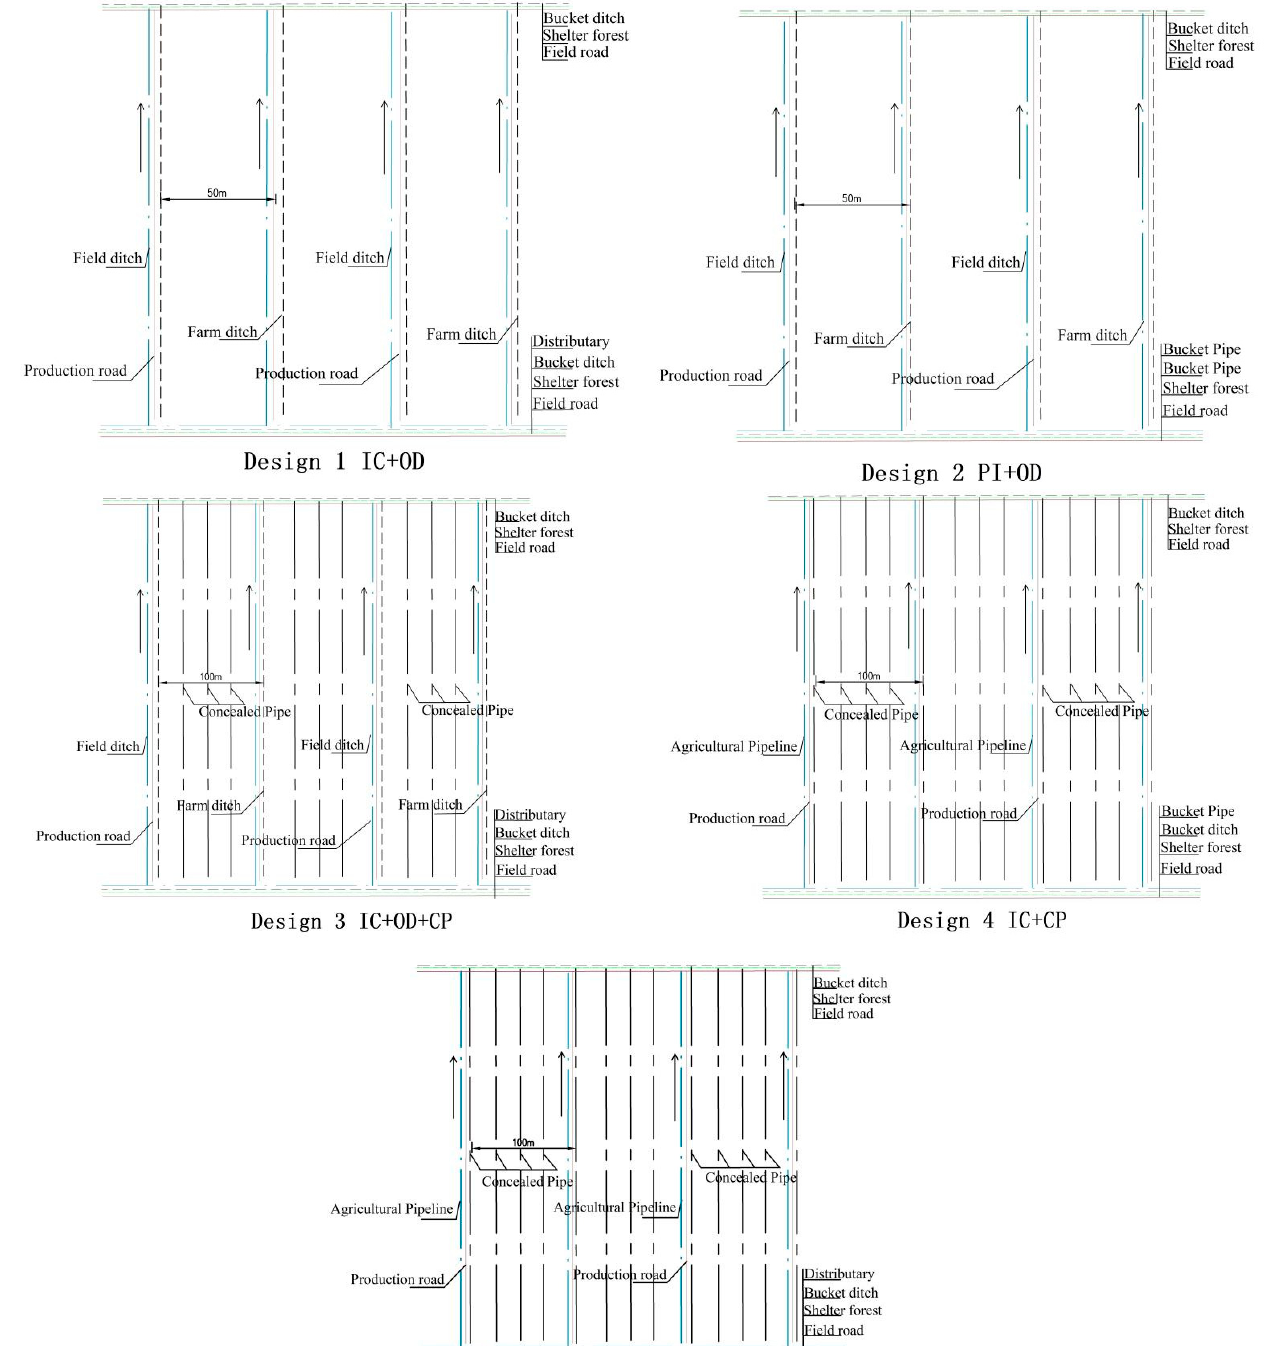
Figure 2. Design schematics for various irrigation and drainage